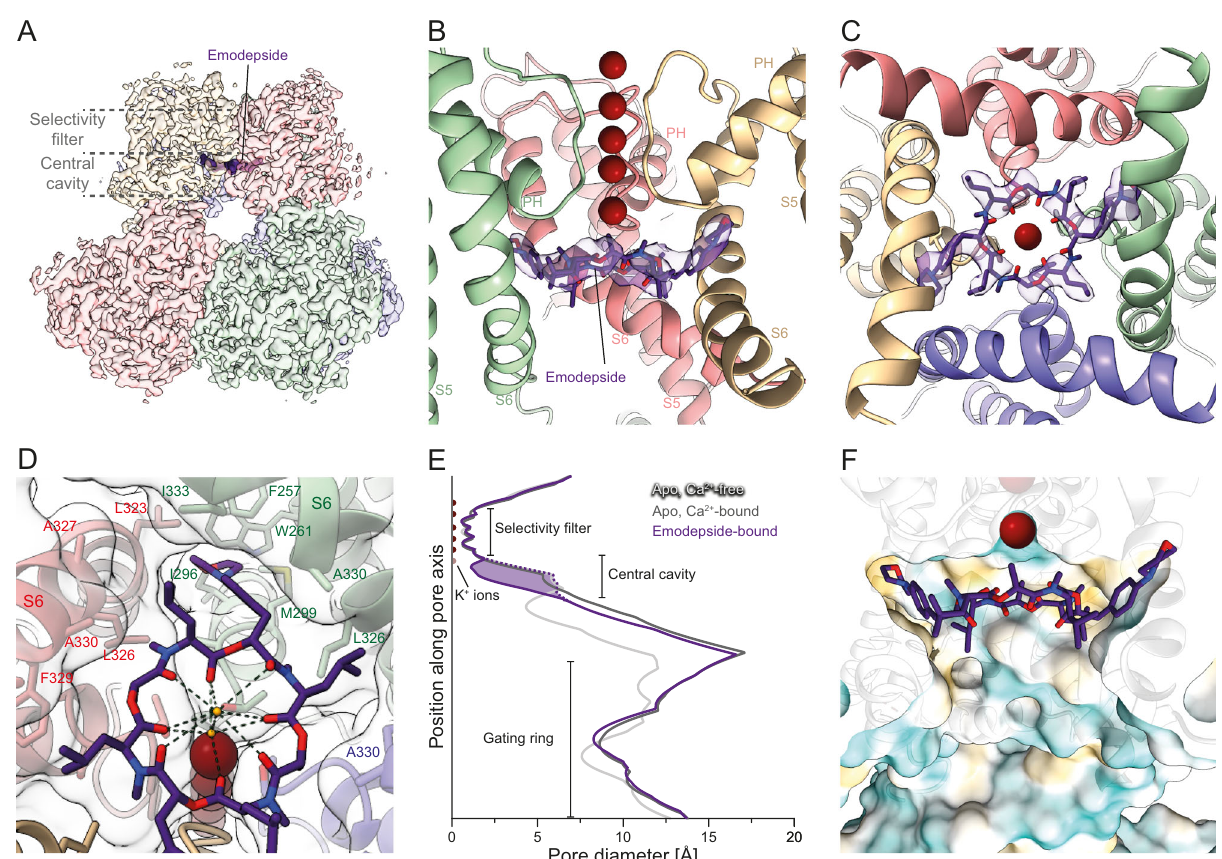
Fig. 5 Emodepside acts as an additional selectivity fi lter layer. A Cryo-EM reconstruction of emodepside-bound Slo colored by the macromolecular chain. Emodepside is shown as a dark purple surface. B View of the emodepside-bound cavity shown from the side. One of the four macromolecular chains was omitted to allow an unobstructed view into the internal pore. Emodepside is shown as sticks and is surrounded by the experimental Coulomb potential map (faint purple). C View from the cytosol into the emodepside-bound cavity illustrating that the central opening in the emodepside is wide enough to translocate K + ions. D Close-up of the emodepside binding site showing how the molecule fi ts on the intracellular entryway and the morpholino and isobutyl side chains reach into pockets between the S6 helices of Slo. Two water molecules that are stabilized by emodepside are shown as small red spheres, and hydrogen bonds between the emodepside and the waters are indicated by dashed lines. E Pore diameter plot of the emodepside-bound conformation (purple) as well as both apo states (gray). The pore is only slightly wider at the emodepside position than at the selectivity fi lter. The purple dashed line indicates the pore diameter of the emodepside-bound conformation with emodepside omitted from the structure, and the light purple area the contribution of emodepside to the narrower pore. Apart from the constriction caused by the emodepside itself, the pore width of the emodepside-bound conformation of Slo is very similar to the Ca 2 + -bound apo state. F Cut-open surface representation of the pore around the emodepside-bound cavity colored in a gradient from cyan over white to yellow according to increasing molecular lipophilicity potential (MLP). The cavity appears to be similarly wide and hydrophilic as in the Ca 2 + -bound apo state (Fig. 3C), and less hydrophobic compared to the Ca 2 + -free apo state (Fig. 3D) and the verruculogen-bound state (Fig. 4F). At the same time, the emodepside occupies the position where incoming K + ions would be focused before entering the selectivity fi lter and adds another layer of the pore through which the ions have to be